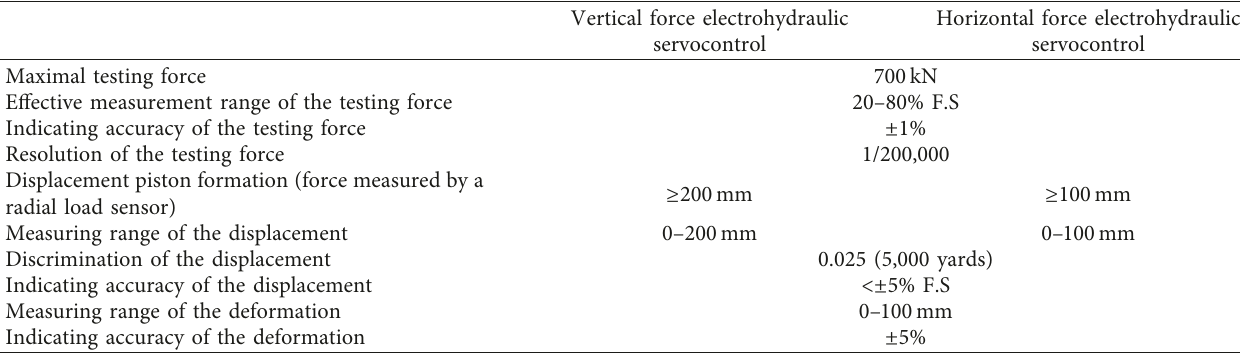
Figure 3: Flow direction of the seepage-stress coupling test system. Table 1: Main technical parameters of the normal force and shear force electrohydraulic servo systems.